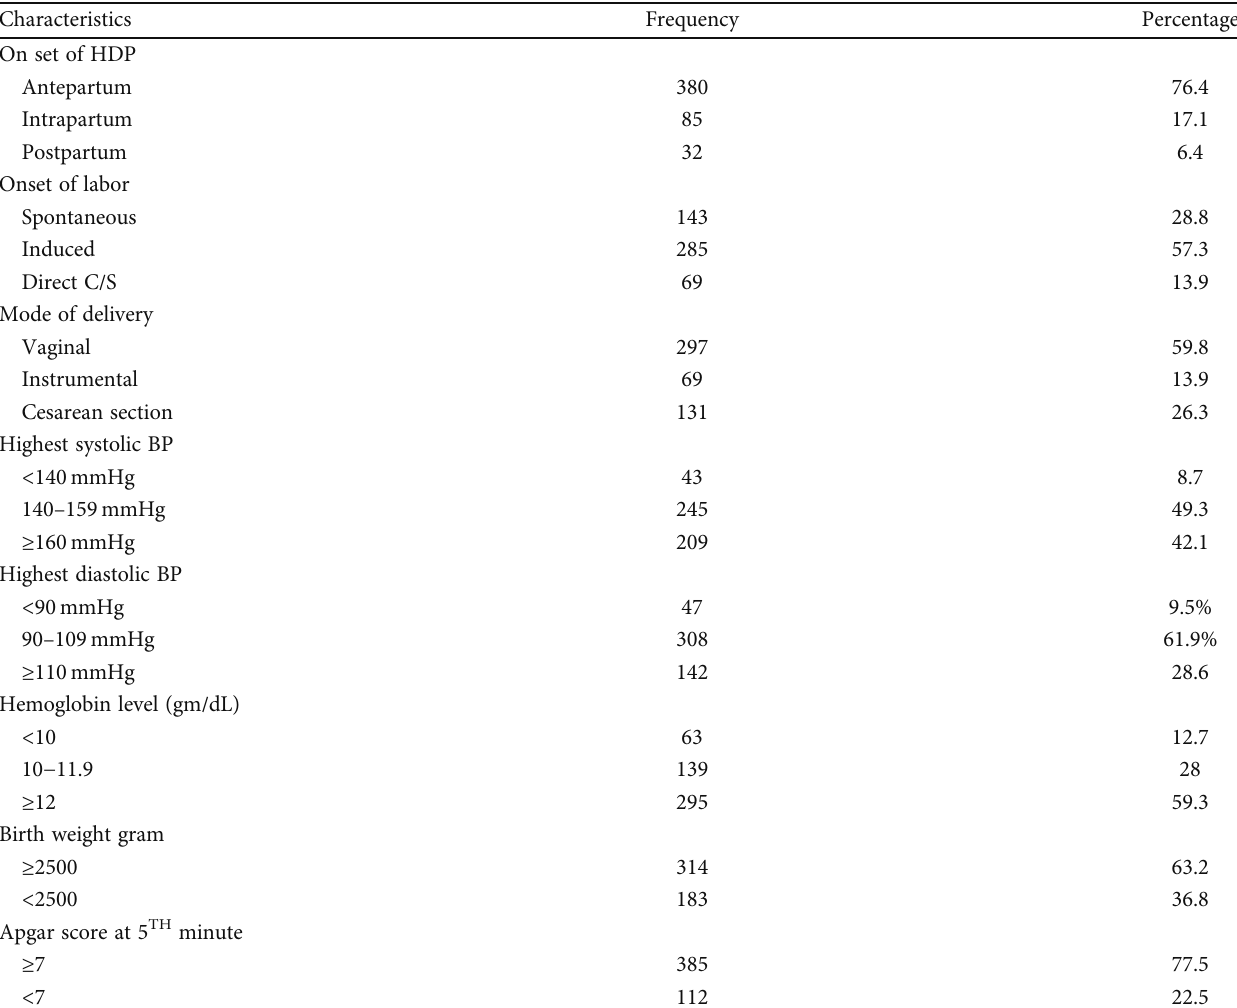
Table 2: Characteristics of mothers with HDP during admission and labor from July 01, 2014, to June 31, 2019, at Suhul Hospital, Northwest Tigray, Ethiopia,